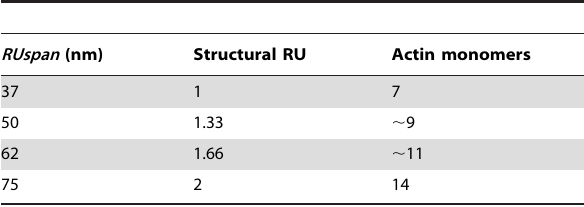
Table 2. Hill-fit parameters to steady-state force and thin filament activation responses versus pCa.